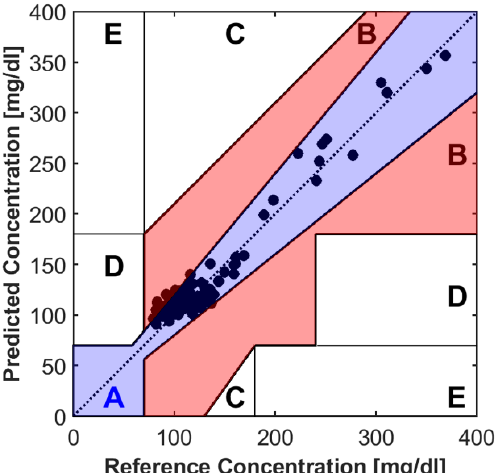
Figure 9. The Clarke error grid analysis of estimated and reference BGL. Reprinted with permission from [44].